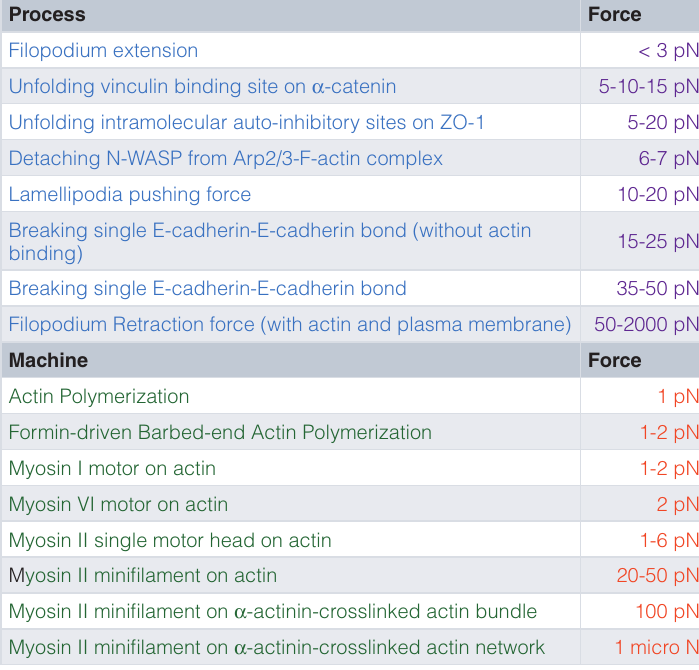
Table 1. Magnitude of forces. ( Upper ) Different processes require different levels of force. ( Lower ) Different molecular mechanisms produce different levels of